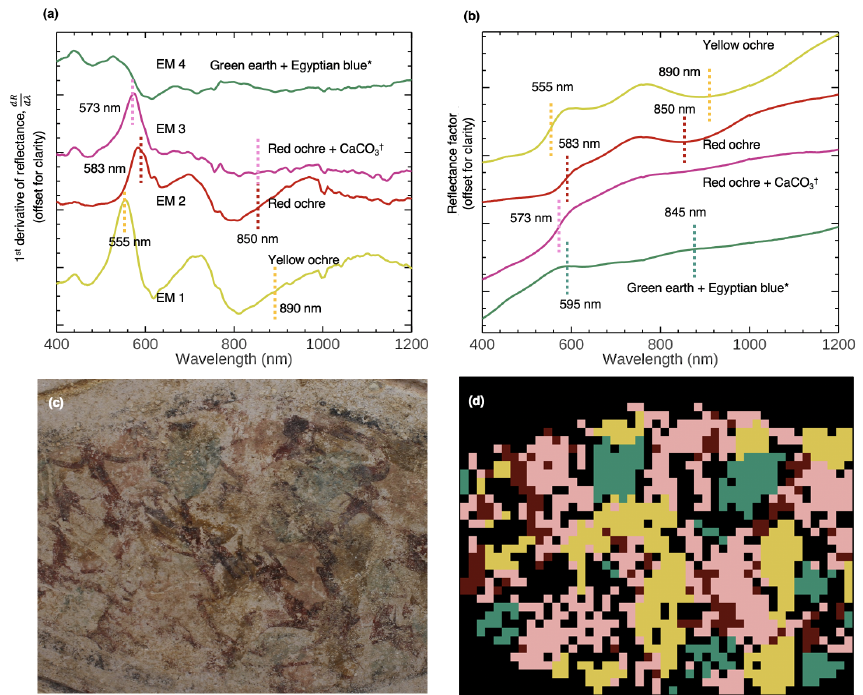
Figure 6. ( a ) The first derivative endmembers of Case Study 2, extracted from the SRS image cube of Imitation marble . ( b ) The reflectance equivalent endmembers of ( a ). * Egyptian blue was not identified by the SRS data. † CaCO 3 was not identified in the VNIR analysis. ( c ) A color image of Imitation marble (266 mm × 150 mm). ( d ) The SAM map showing the distribution of the first derivative endmembers. The endmember corresponding to the yellow paint—EM 1—was identified as goethite- rich yellow ochre by the first derivative peak at 550 nm (attributed to the Fe 3 +